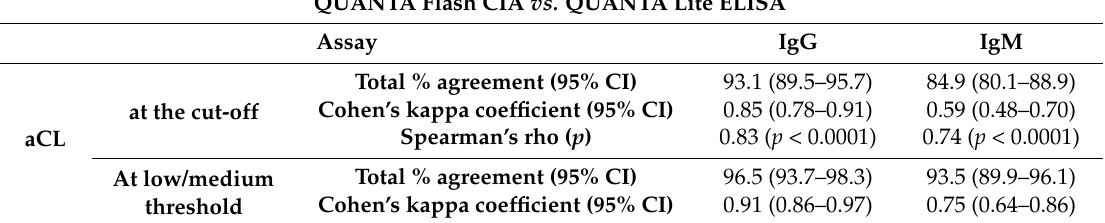
Table 2. Qualitative agreement and quantitative correlation between chemiluminescent immunoassay (CIA) and enzyme-linked immunosorbent assay (ELISA) methods at the assay-specific cut-off values and at assay-specific low/medium